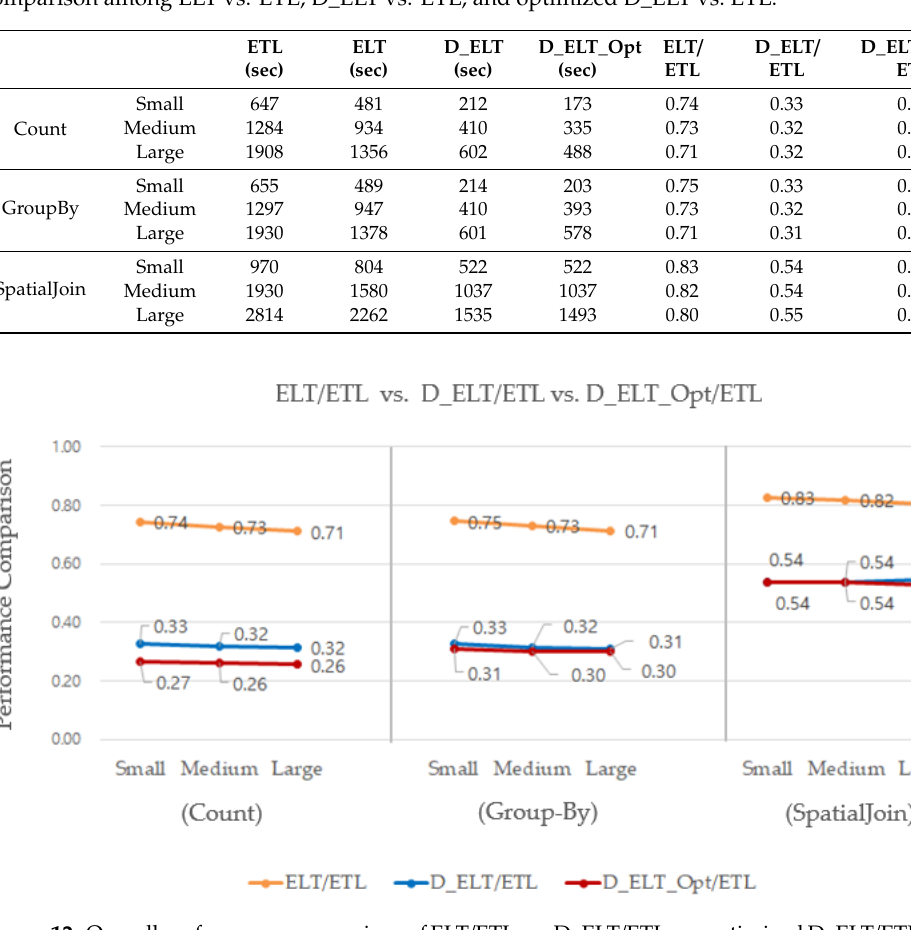
Table 5. Overall performance of ETL, ELT, D_ELT, optimized D_ELT (in seconds), and performance comparison among ELT vs. ETL, D_ELT vs. ETL, and optimized D_ELT vs. ETL.